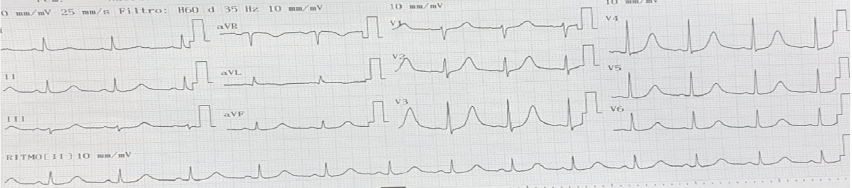
Figure 3: Initial electrocardiogram in a high-complexity hospital. Sinus rhythm, heart rate 75 bpm, QTc 521, QRS 70, PR 154, and prominent precordial T waves.